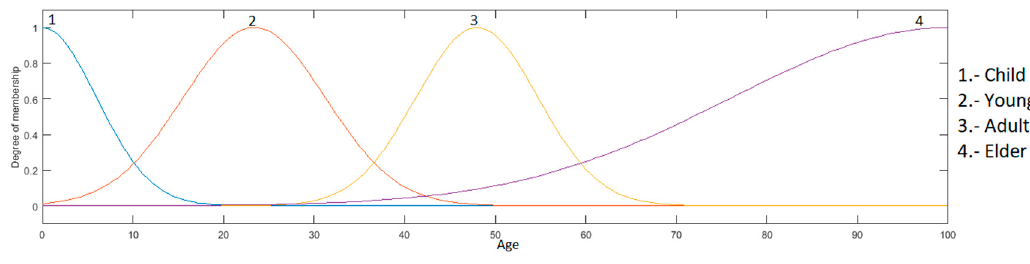
Figure 7. Input age.